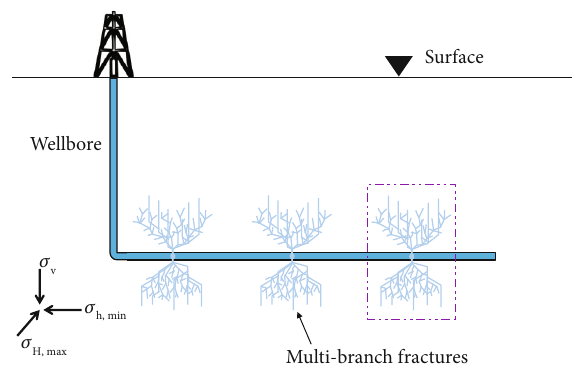
Figure 2: Conceptual model for hydraulic fracturing in shale reservoir with preexisting natural fractures. Horizontal well injection initiates multibranch fractures. I delimit the study to one multibranch fracture highlighted with a purple dashed